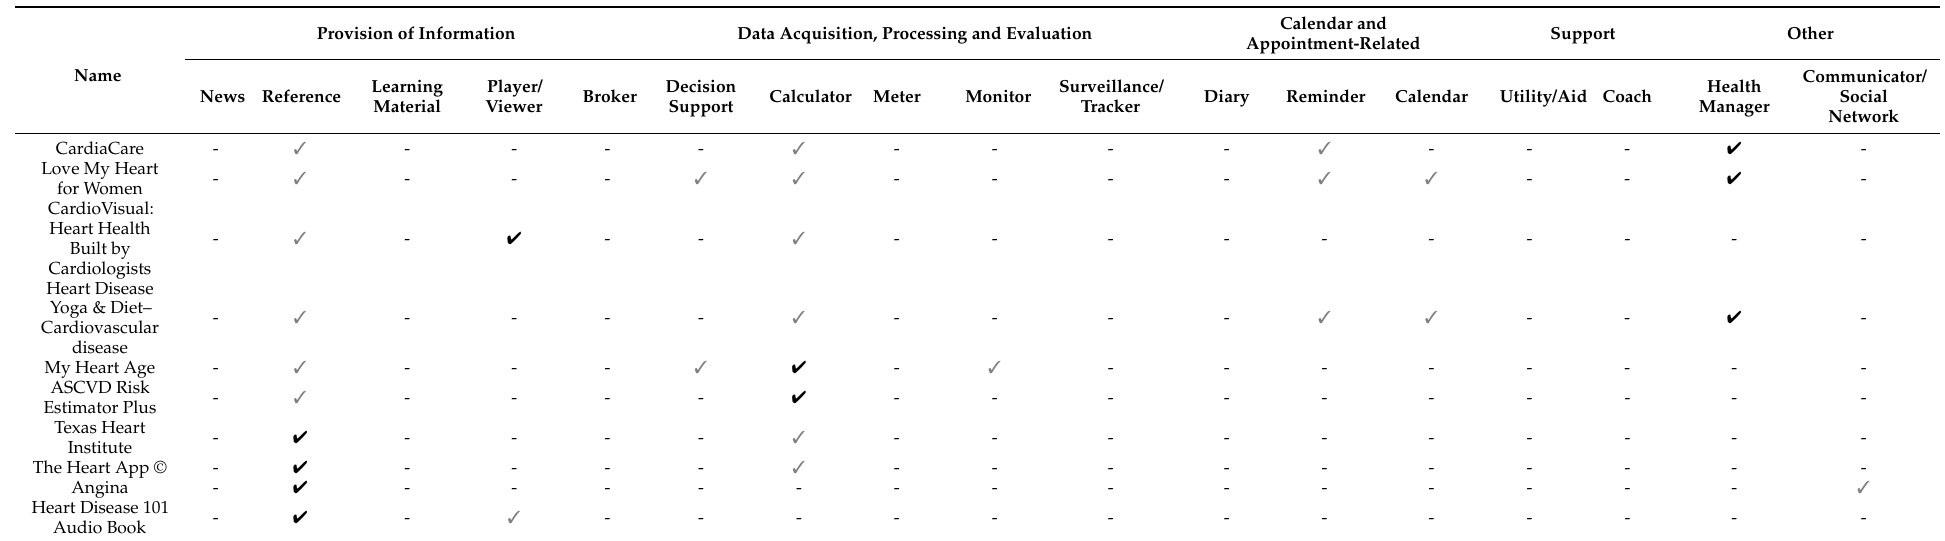
Table 3. Employed functions per included MHA for the ten highest-rated